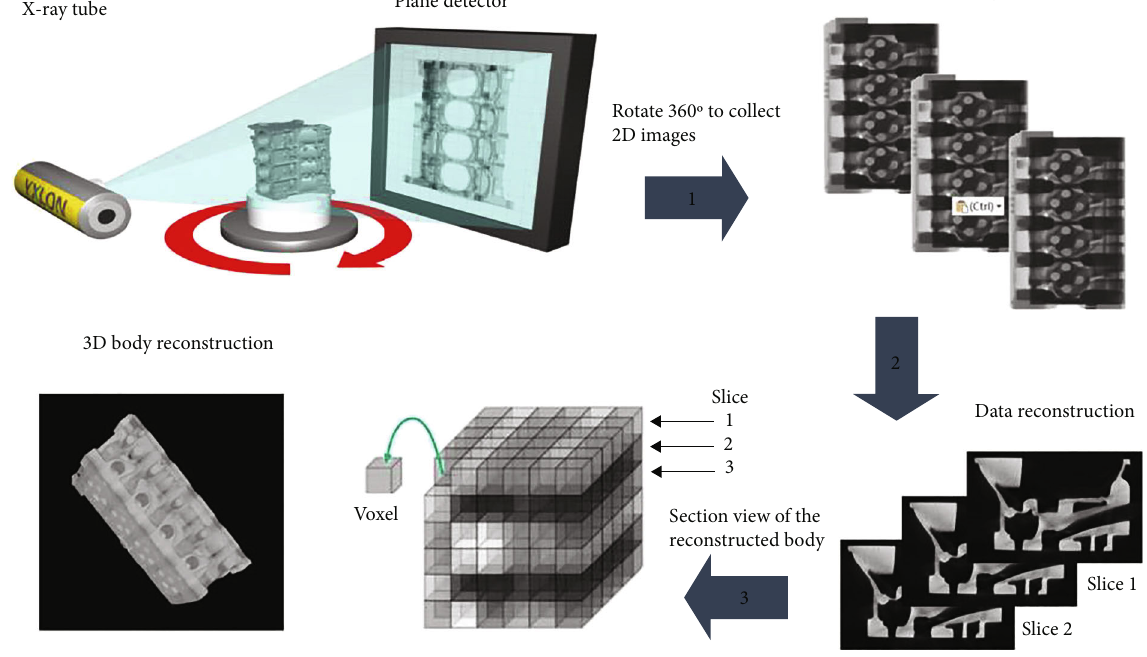
Figure 7: Detection process of the FF35 CT industrial computed tomography